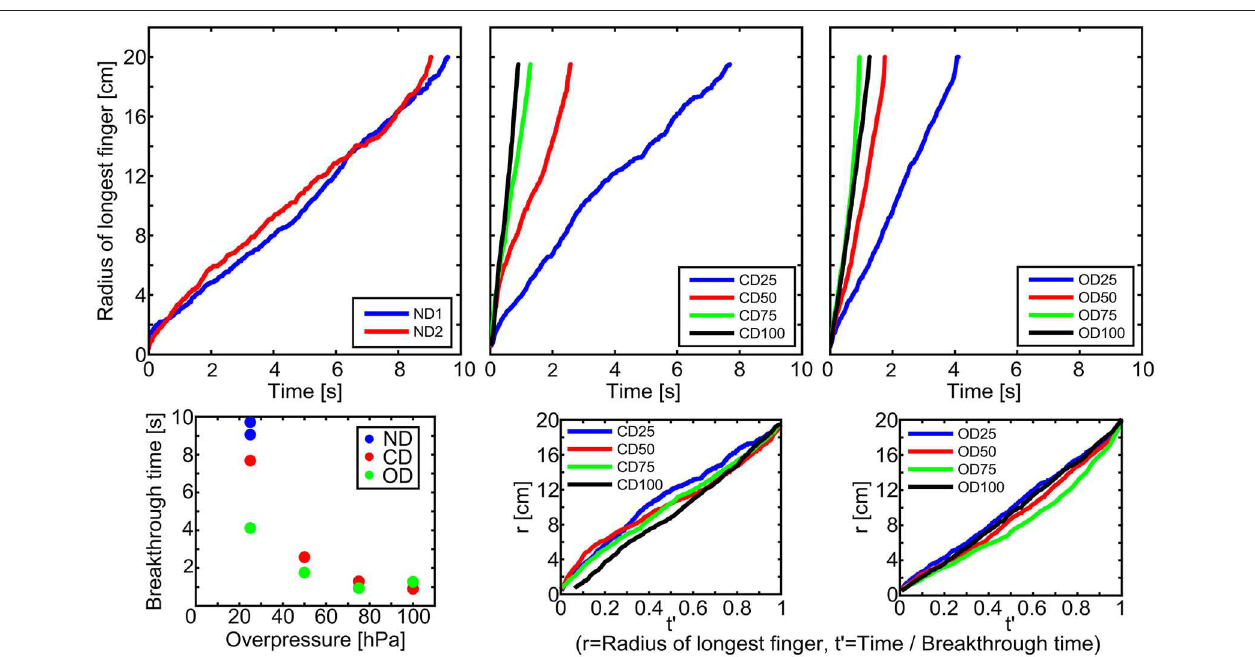
FIGURE 5 | Radius of longest finger as function of time for all the experiments, grouped by boundary condition. From top left to top right: non-deformable, confined deformable, and open deformable. The injection pressure in both ND experiments is 25 hPa, while the number in the experiment names for the CD and OD experiments gives the injection pressure in hPa. In the bottom plots below the deformable experiments, time is divided by breakthrough time to compare the shape of the curves, and the bottom left plot shows the breakthrough times as function of overpressure for all the experiments.